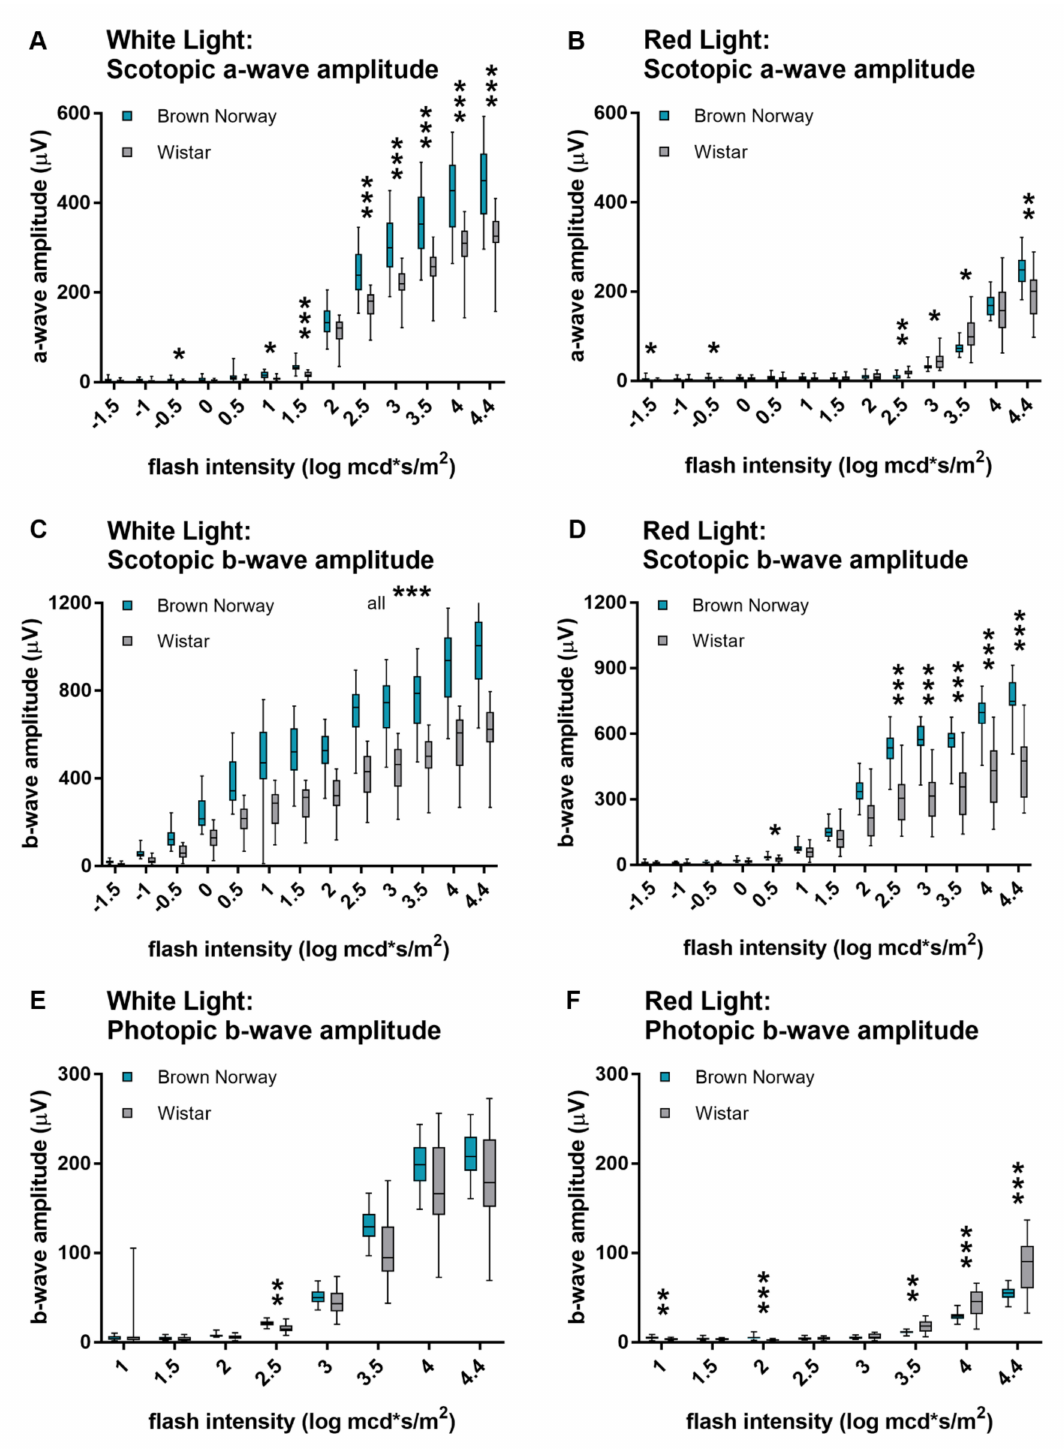
Figure 4. Comparison of red- and white-light induced ERG responses between Brown Norway and Wistar rats. ERG responses of white ( A , C , E ) and red ( B , D , F ) light in Brown Norway and Wistar rats. Overall, scotopic a- ( A,B ) and b-wave ( C,D ) amplitudes were larger in Brown Norway than in Wistar rats, for both red and white light. Photopic white-light responses did not di ff er between the two rat strains ( E ). Photopic red light evoked significantly higher b-wave amplitudes in Wistar in comparison to Brown Norway. Statistics: t-test corrected with Holm-Sidak method for multiple comparisons. * p ≤ 0.05, ** p ≤ 0.01, *** p ≤